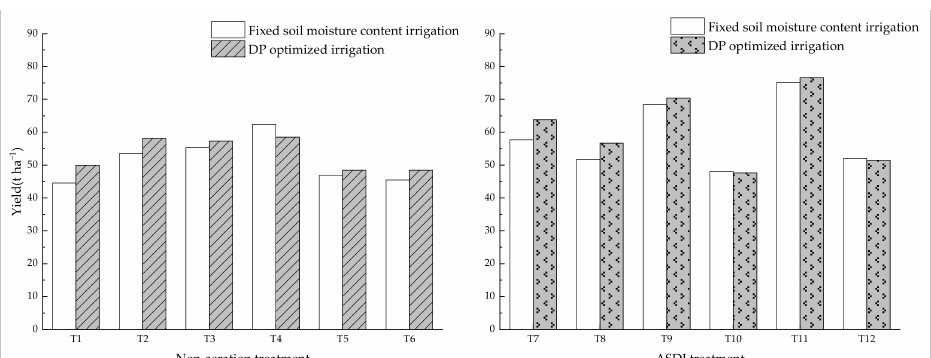
Figure 4. The yield difference between DP optimized irrigation and the fixed soil moisture content irrigation.